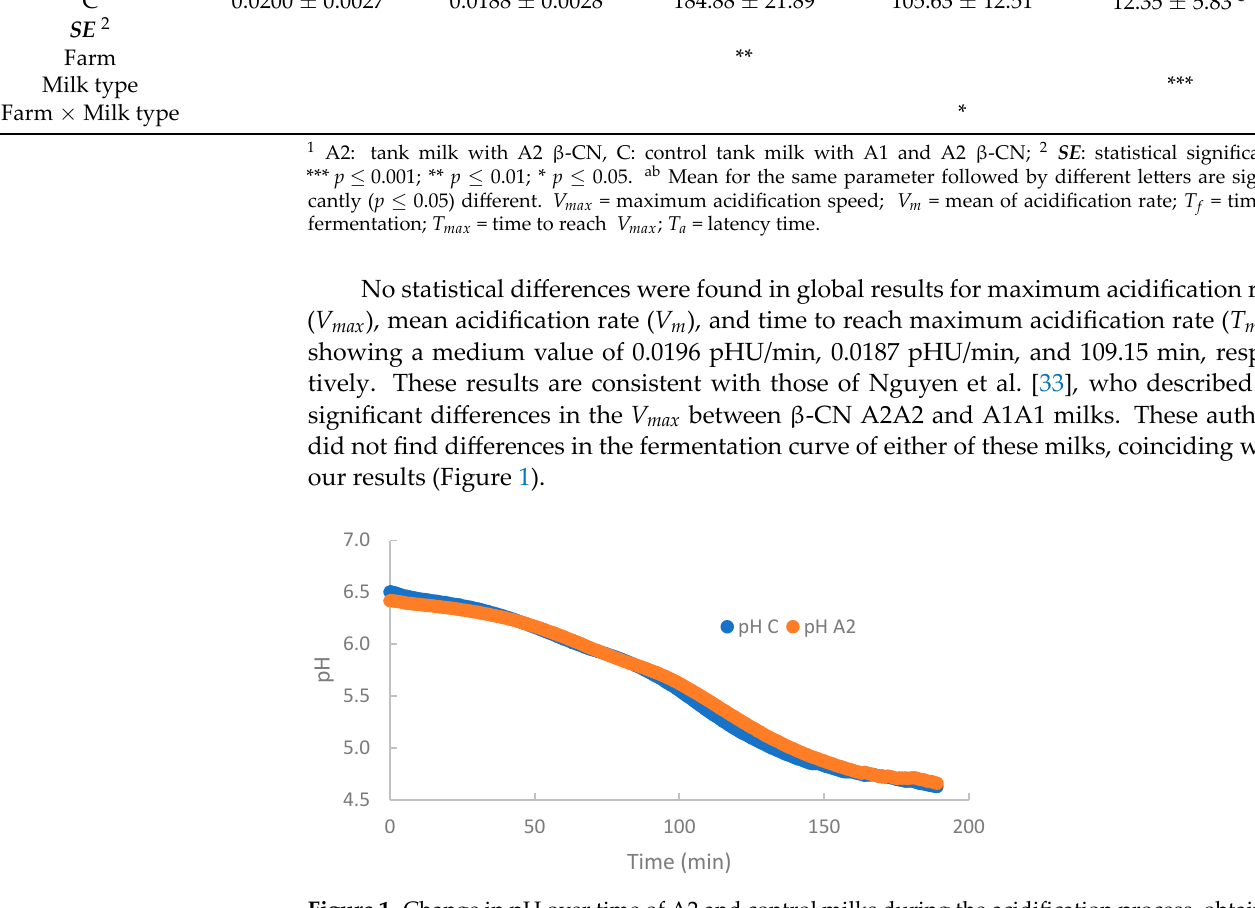
Figure 1. Change in pH over time of A2 and control milks during the acidification process, obtained using a CINAC ® device.